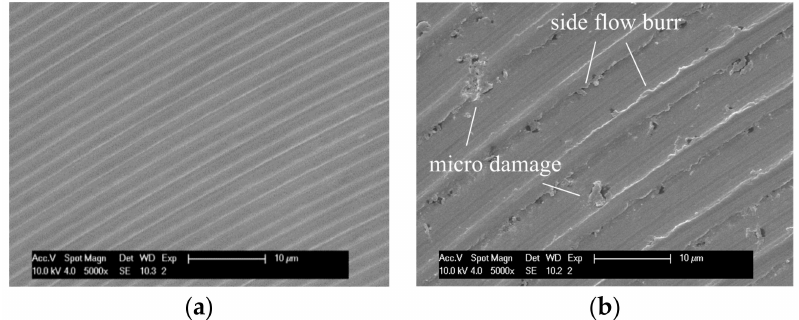
Figure 14. Machined surfaces of groove n1 in test ( a ) TC1: f z = 1 µ m, a p = 2 µ m; ( b ) TC2: f z = 5 µ m, a p = 4 µ